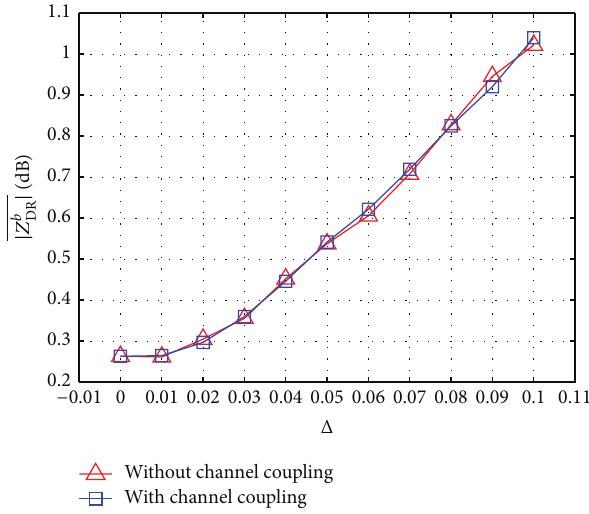
Figure 11: |𝑍 𝑏 DR | of a single spherical scatterer and finite beamwidth.